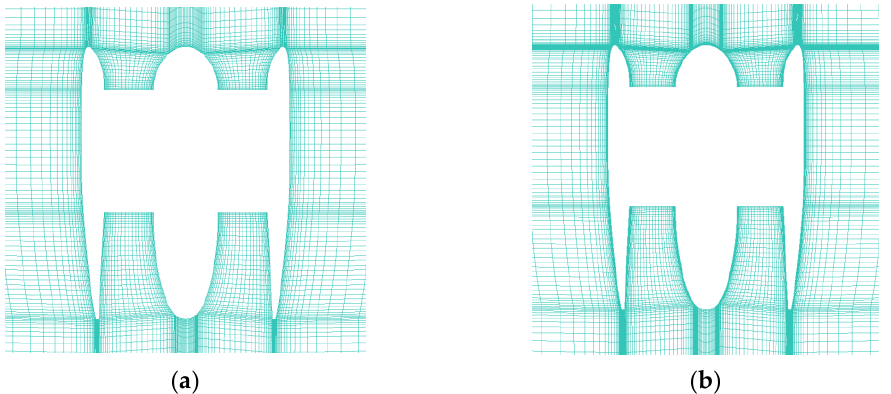
4 of 18 Table 1. Performance comparison of the ducted fan with different blade grids.